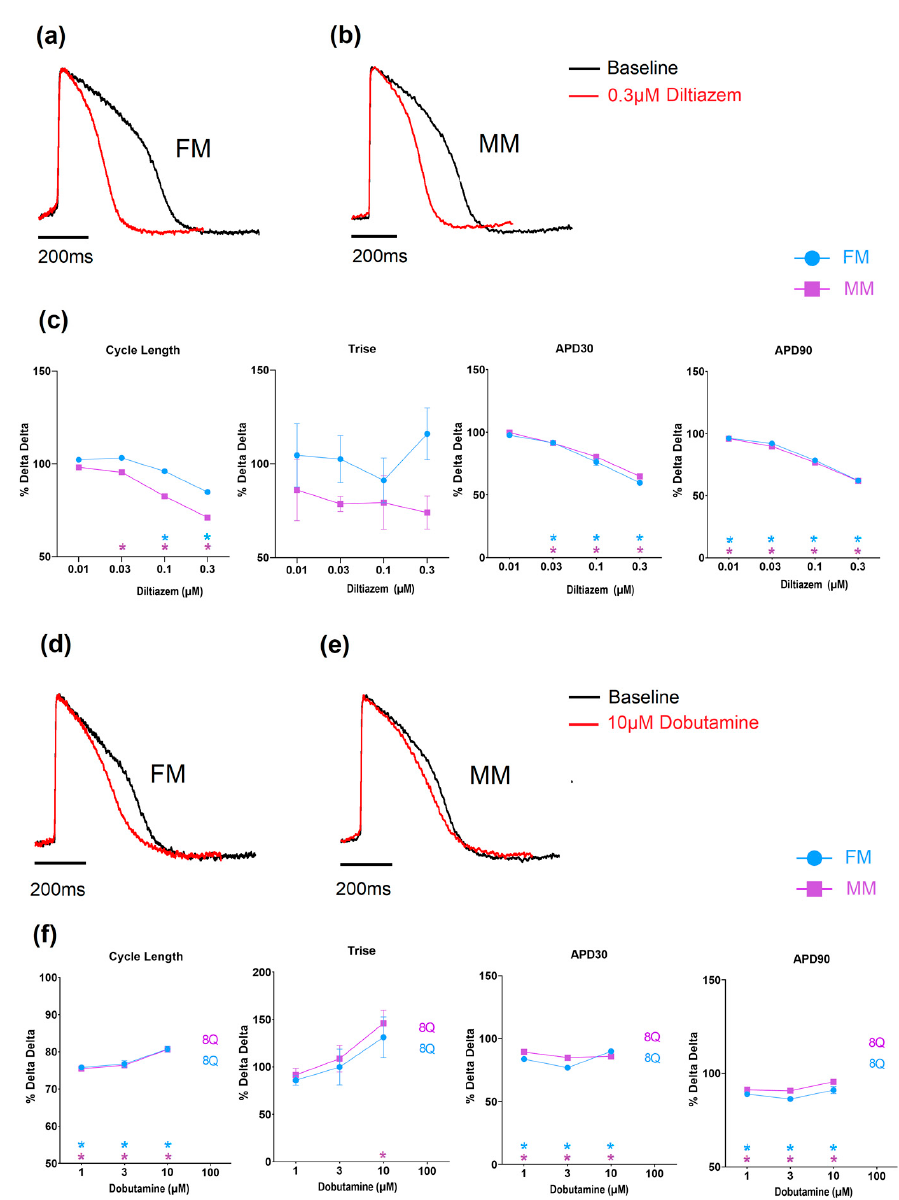
Figure 7. The effect of Diltiazem and Dobutamine on the two models of electrophysiology (Dilti- Figure 7. The e ff ect of Diltiazem and Dobutamine on the two models of electrophysiology azem: ( a – c ), Dobutamine: ( d – f ) (* p < 0.05)). Fibronectin (FM) (blue) and Matrix Plus coated plates (Diltiazem: ( a – c ), Dobutamine: ( d – f ) (* p < 0.05). Fibronectin (FM) (blue) and Matrix Plus coated (MM, plates (MM, violet).